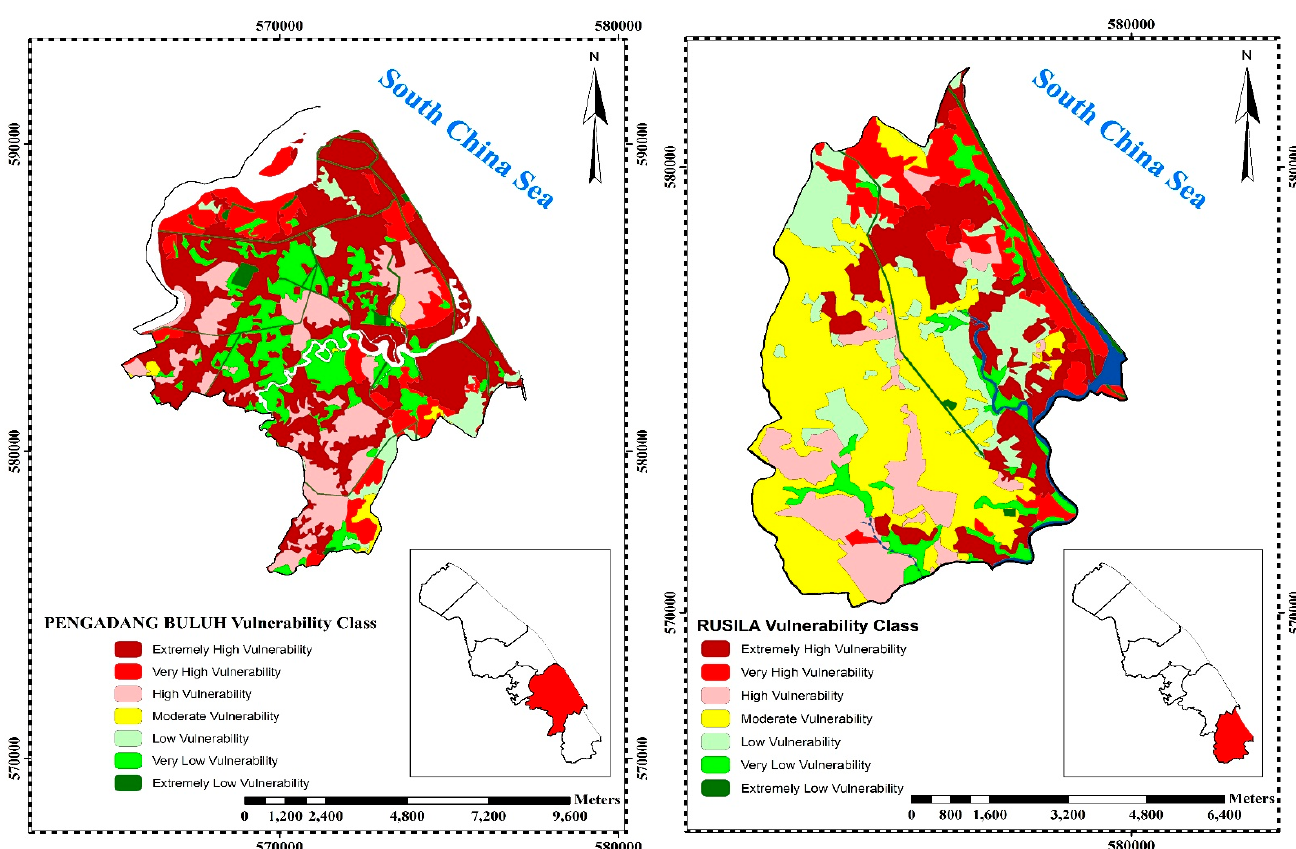
Figure 3. Final vulnerability map and sensitive zones.